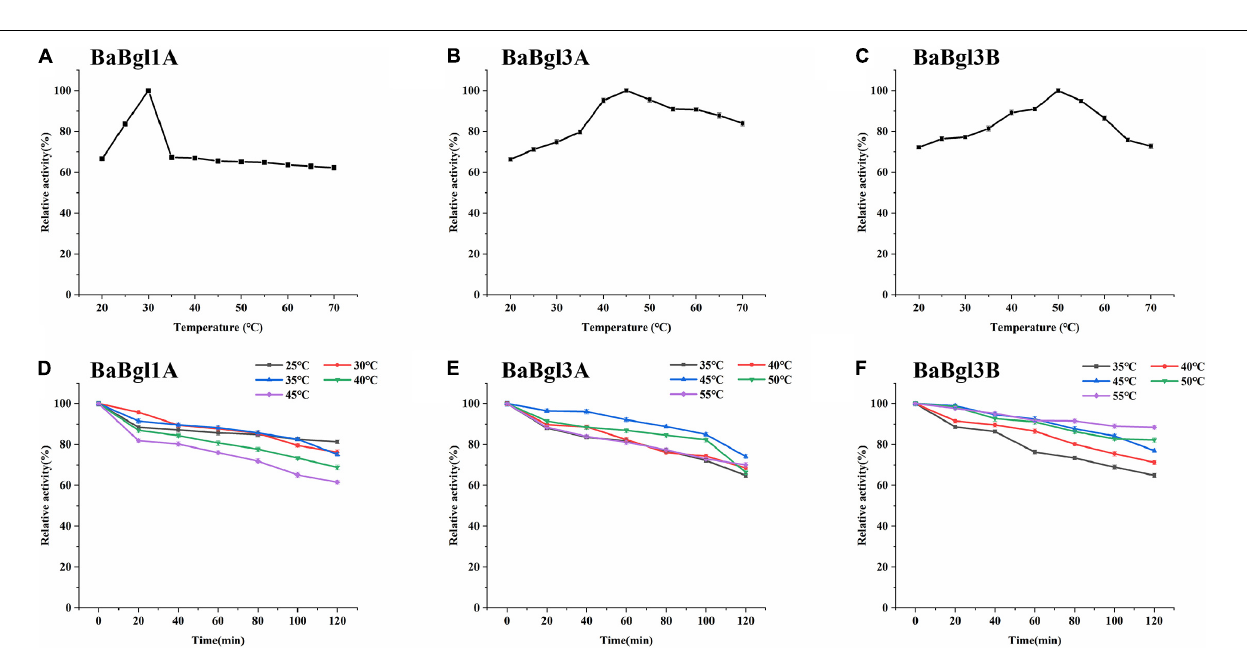
FIGURE 2 | pH profiles of the purified recombinant enzymes (BaBgl1A, BaBgl3A, and BaBgl3B). The effects of pH and stability on BaBgl1A are shown in (A,D) . The effects of pH and stability on BaBgl3A are shown in (B,E) . The effects of pH and stability on BaBgl3B are shown in (C,F) . All tests of pH stability were performed at 4 ◦ C for 12 h. Values are mean ± SD from three biological replicates.